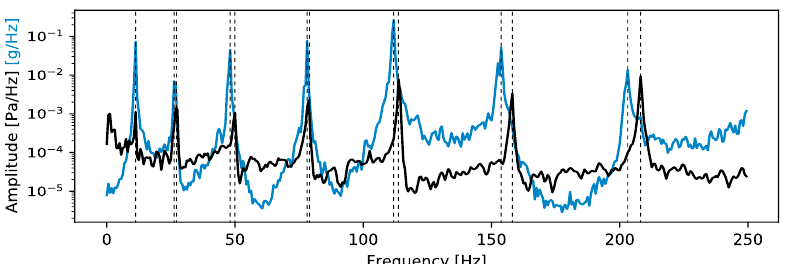
Figure 15. Detrimental effects of contact sensors. Frequency shift caused by the added mass and inertia of accelerometers and other instrumentation fixed to tie-rod B5 in Palazzo Arcivescovile. The black line is the Linear Spectrum of the microphone signal, the lighter one is that of the